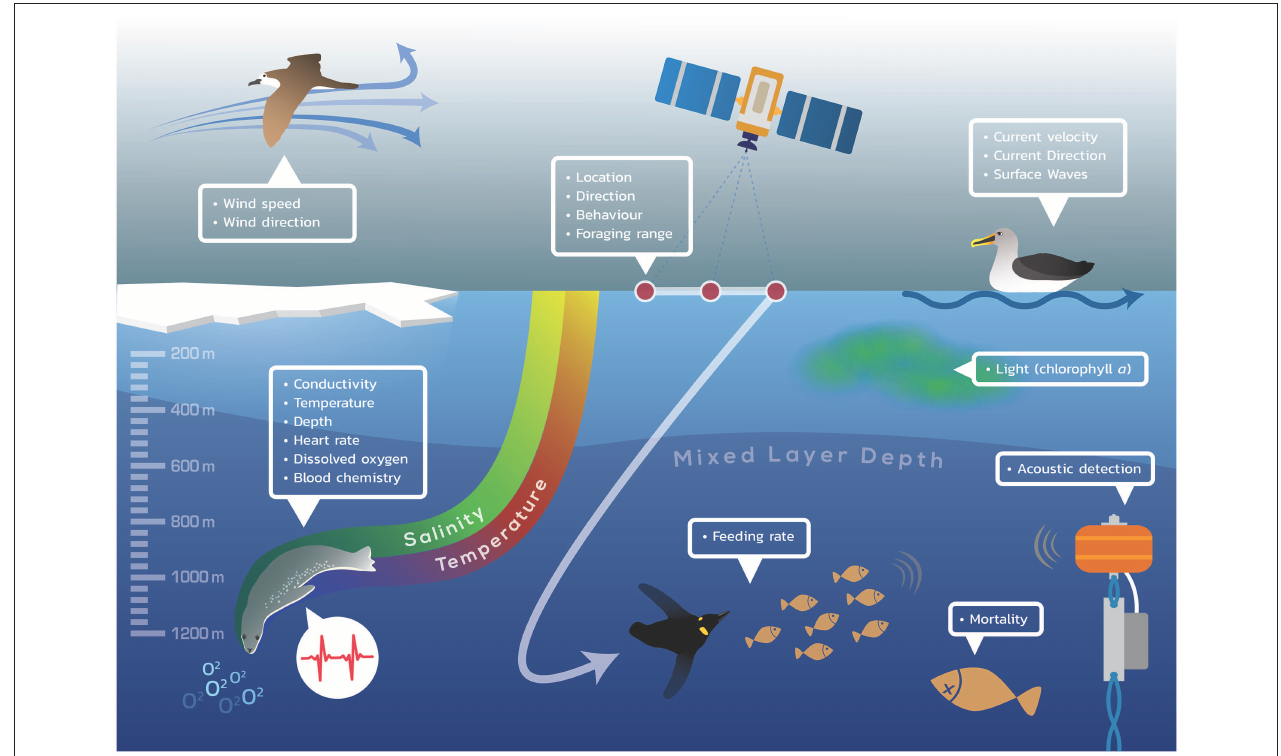
FIGURE 1 | Schematic illustrating the many parameters that can be measured by animal-borne packages, using archival, acoustic, or satellite telemetry. The environmental, physiological, and ecological data collected by the illustrative marine animals (penguin, seabird, fish, seal) may be measured in multiple ways and stored or transmitted or